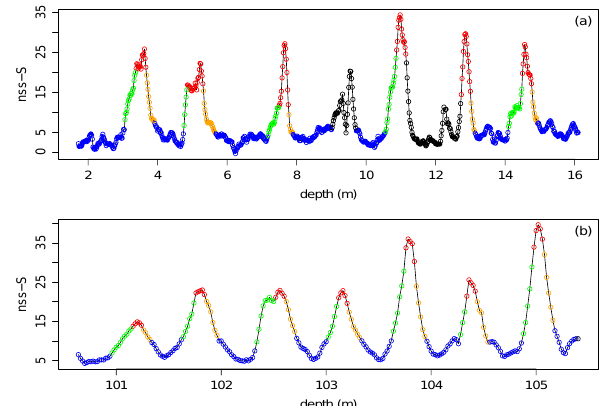
Fig. 11. The effect of ν on the probability distribution obtained for the number of annual troughs in the dating of the NGRIP ice-core (1440.49–1464.81m) using its log NH 4 and Ca signals. Each circle has area proportional to the probability of a particular number of troughs. (a) NH 4 , second thinning. (b) NH 4 , fourth thinning. (c) Ca, second thinning. (d) Ca, fourth thinning.